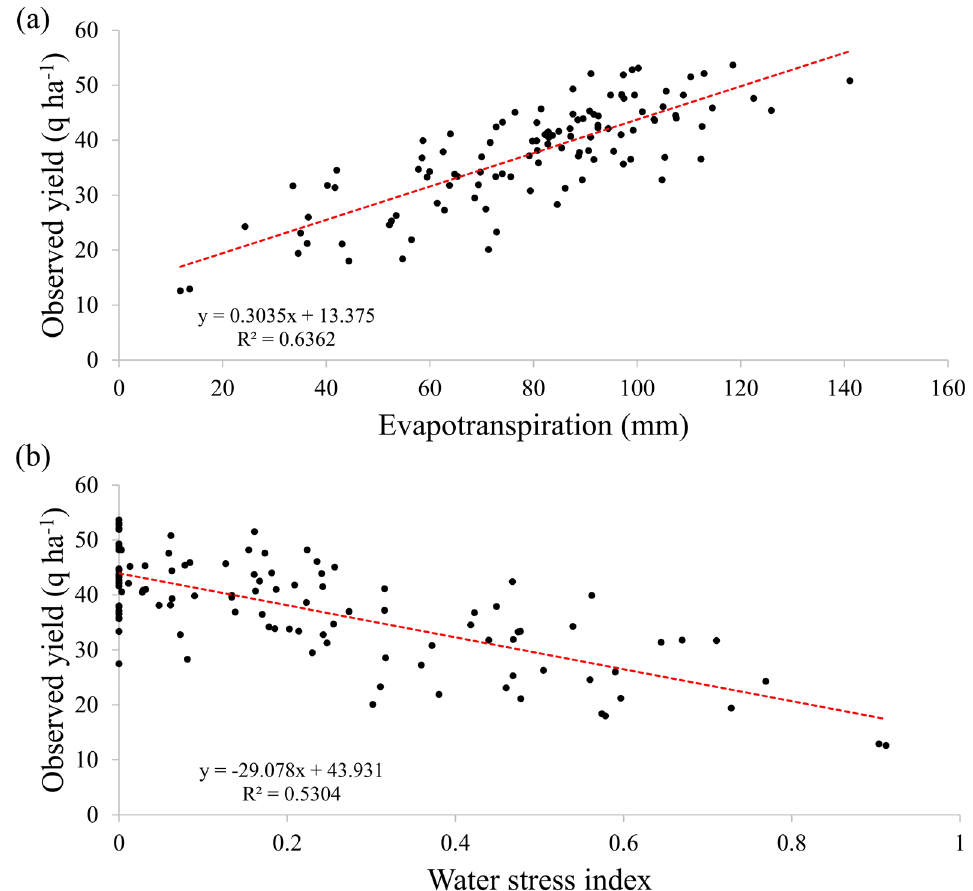
Figure 2. Relationship between observed soybean grain yield and the two first contributing eco- climatic factors from End of Pod to Physiological Maturity. ( a ) Sum of evapotranspiration. ( b ) Water stress index (0 = no stress, 1 = high stress). Water stress index and sum of evapotranspiration were simulated daily by the CROPGRO-soybean model.